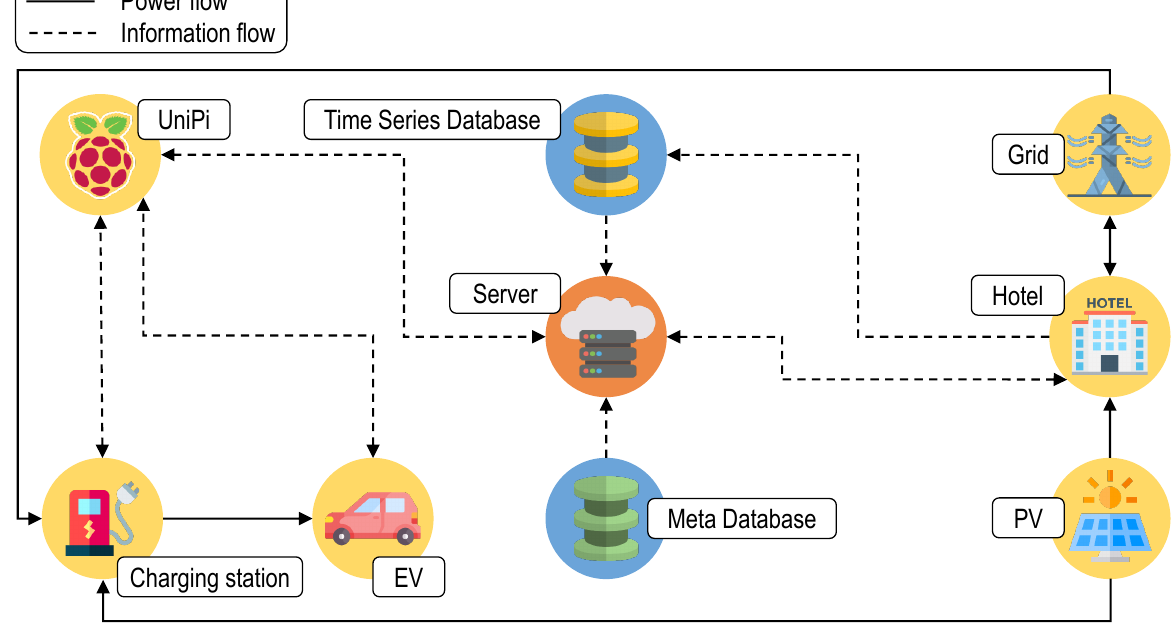
Figure 3. Blockchain system